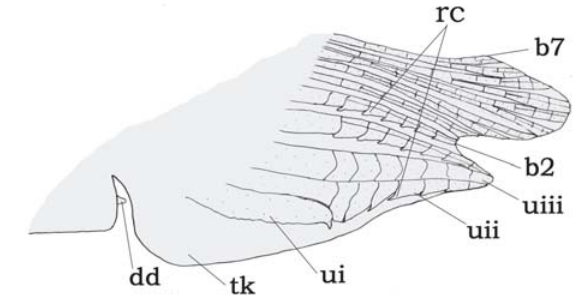
Fig. 42. Male modified anal fin of Tatia strigata , MCZ 78092, 55.0 mm SL. Left side lateral view. Abbreviations: b2 , branched second ray; b7 , branched seventh ray; dd , deferent duct; rc, retrorsely curved denticulation; tk , tegumentary keel; ui , un- branched first ray; uii , unbranched second ray; uiii , un- branched third ray. Scale bar = 1 9’. Cranial fontanel short, opening restricted to frontal (Fig. 8); mature male genital papilla with thick skin flap around deferent duct; notch present in distal margin of modified anal fin in mature males ( i.e. , central fin rays reduced); third anal-fin ray in males comparatively short, between …………………… Tatia aulopygia (Fig. 7, upper Madeira) 10. Body coloration variable: usually with ellipsoid spots present on body and caudal fin (Fig. 27 b,c), or sometimes coloration uniformly brown; caudal fin pale (Fig. 27a); large adult specimens (>72 mm SL) usually with prevomerine teeth; male modified anal fin with 3-6 elongate antrorse denticulations along distal anterior margin of third un- branched ray (Fig. 29) …………………… Tatia intermedia (Fig. 27, Guyana, Suriname, French Guiana, Amapá and eastern Pará, Brazil, lower Amazon and Tocantins) 10’. Body coloration mottled with irregular blotches or stripes; caudal fin with whitish spots or blotches; no prevomerine teeth, even in large adult specimens; male modified anal fin with sharp distal tip and 1-3 short antrorse denticula- tions along distal anterior margin of third unbranched ray (Figs.14 and 20) …………………………………………… 11 11. Head width 76.0-80.1% HL; mouth width 48.1-52.3% HL; pectoral-fin spine uniformly dark brown, without trans- verse bands; anal-fin rays usually iii, 6-7; modified anal fin in mature males with first unbranched ray unsegmented (Fig. 21) …................ Tatia dunni (Fig. 19, upper Amazon) 11’ . Head width 86.6-93.4% HL; mouth width 54.0-59.7% HL;